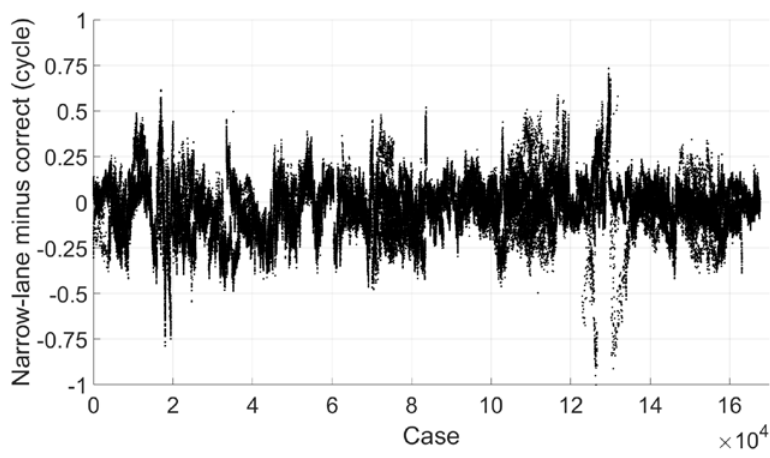
Figure 24. Narrow-lane ambiguity minus correct integer ambiguity (GPS).